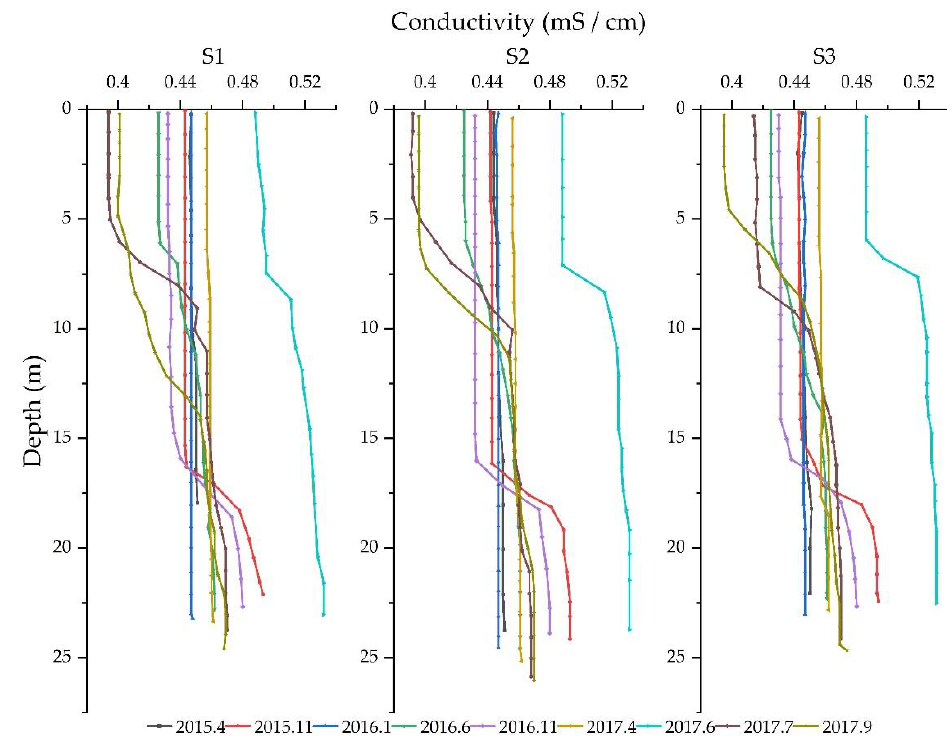
Figure 5. Vertical profile of conductivity in Lake Yangzong.